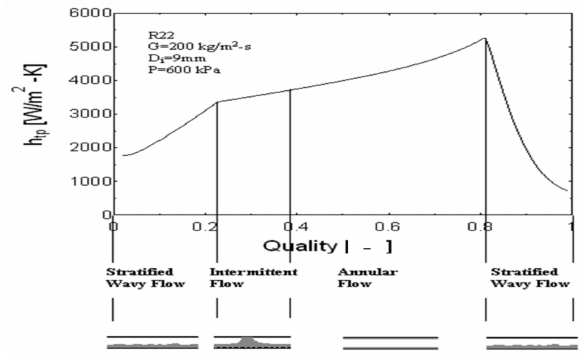
Figure 5. Local flow boiling coe ffi cient predicted with the Thome [21] flow-pattern-dependent evaporation